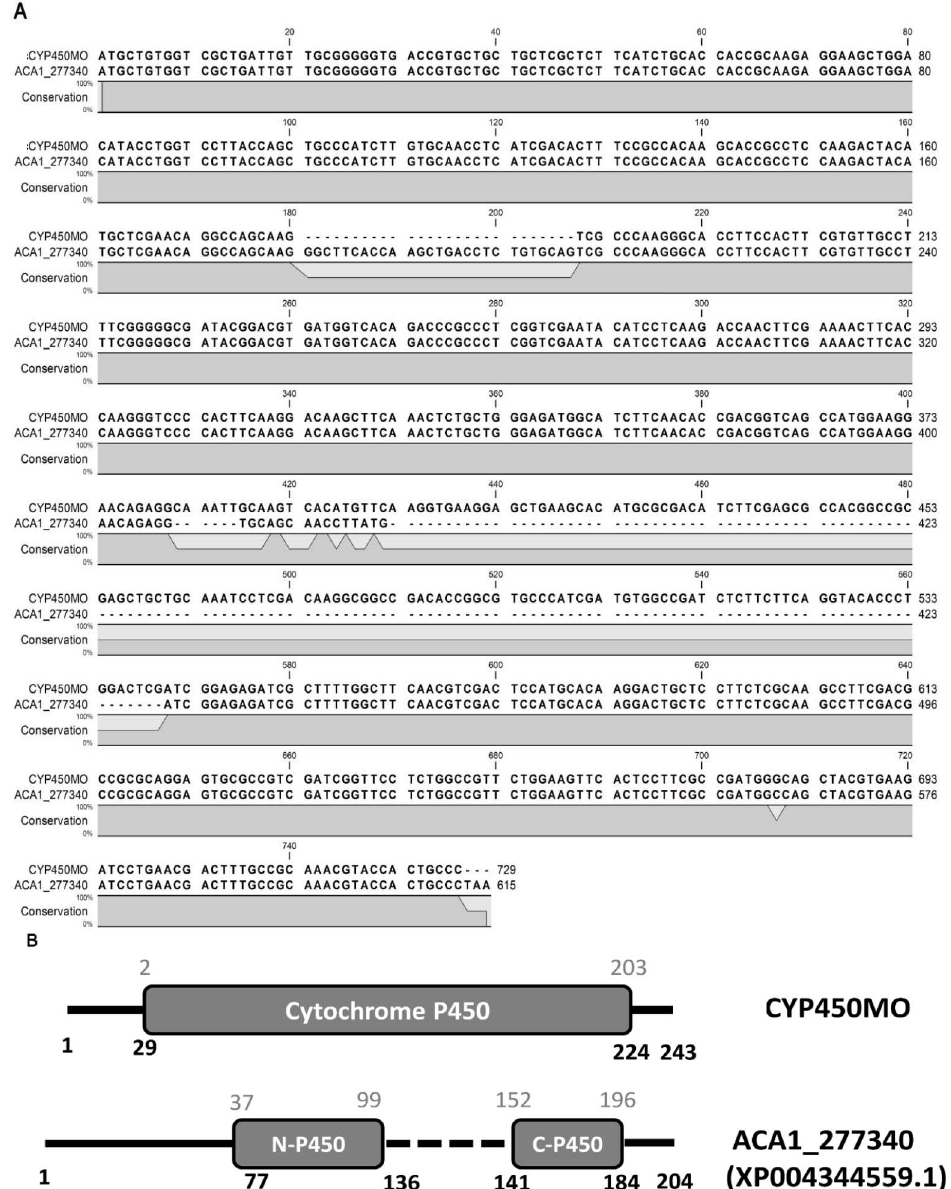
Figure 2. Sequence alignment between CYP450MO and ACA1_277340. (A) Alignment of coding sequences. (B) Schematic representation of the alignment of the cytochrome P450 domain. The numbers in black indicate the position on peptides, while the numbers in grey stand for the position of the hmm model of cytochrome p450 in the pfam annotation